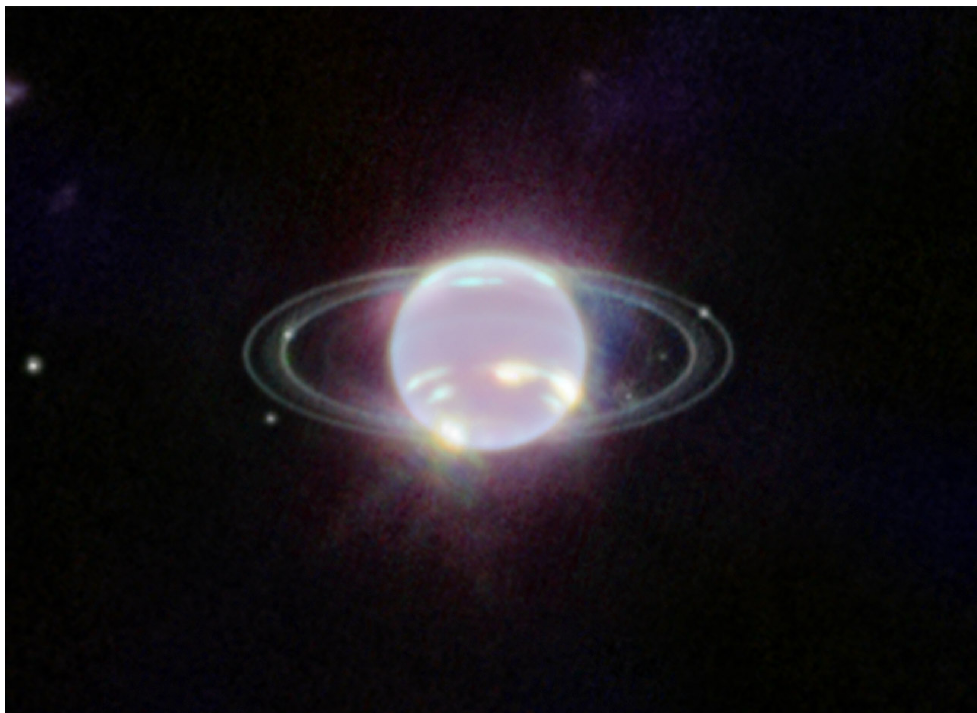
Figure 8. First observation of Neptune from the James Webb Space Telescope (JWST) in the near- infrared. Several discrete cloud features are seen in the northern and souther mid-latitudes. Image credits: